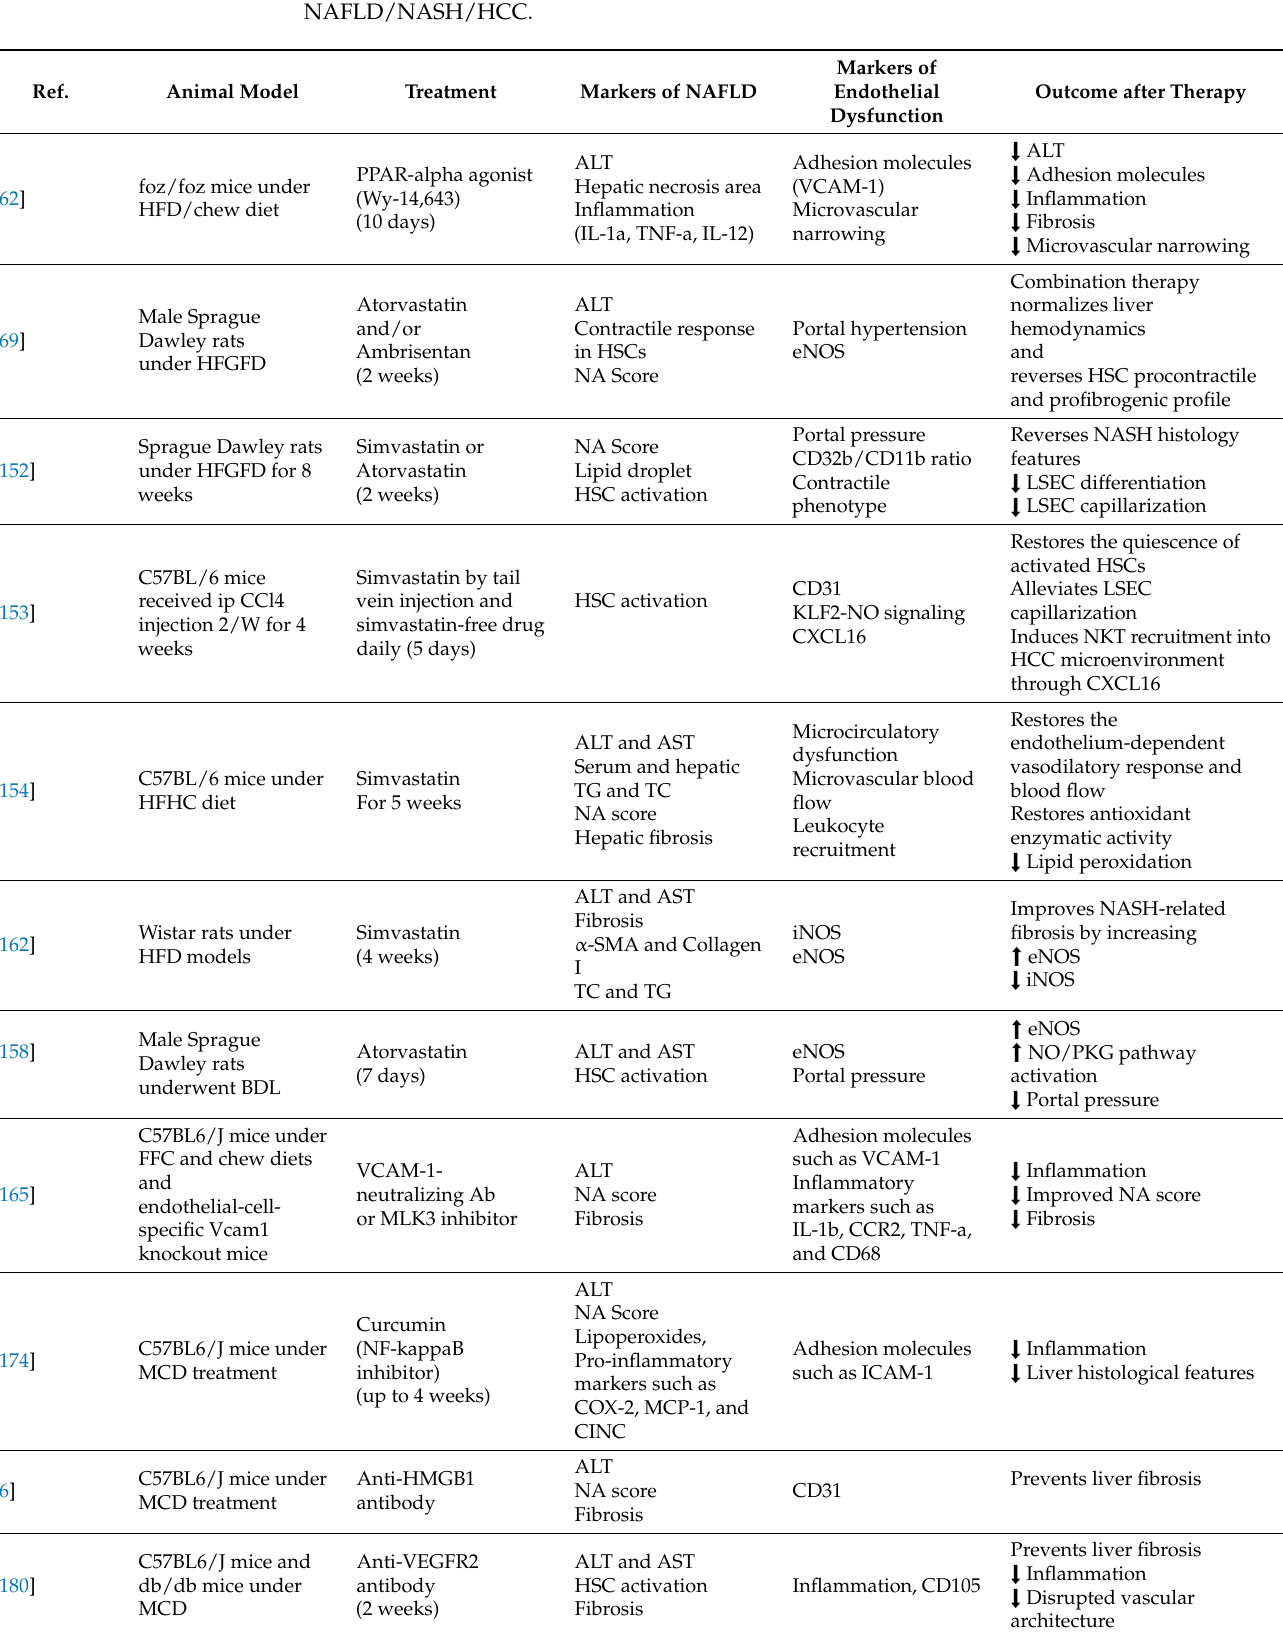
Table 1. Studies targeting endothelial cells as a therapeutic strategy in animal models of NAFLD/NASH/HCC.